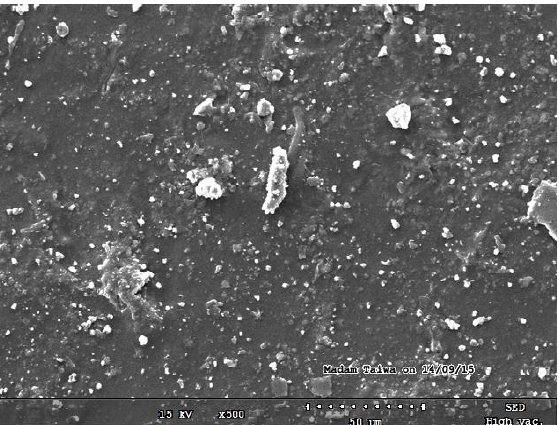
Figure 1. SEM micrograph of pure cassava starch film.